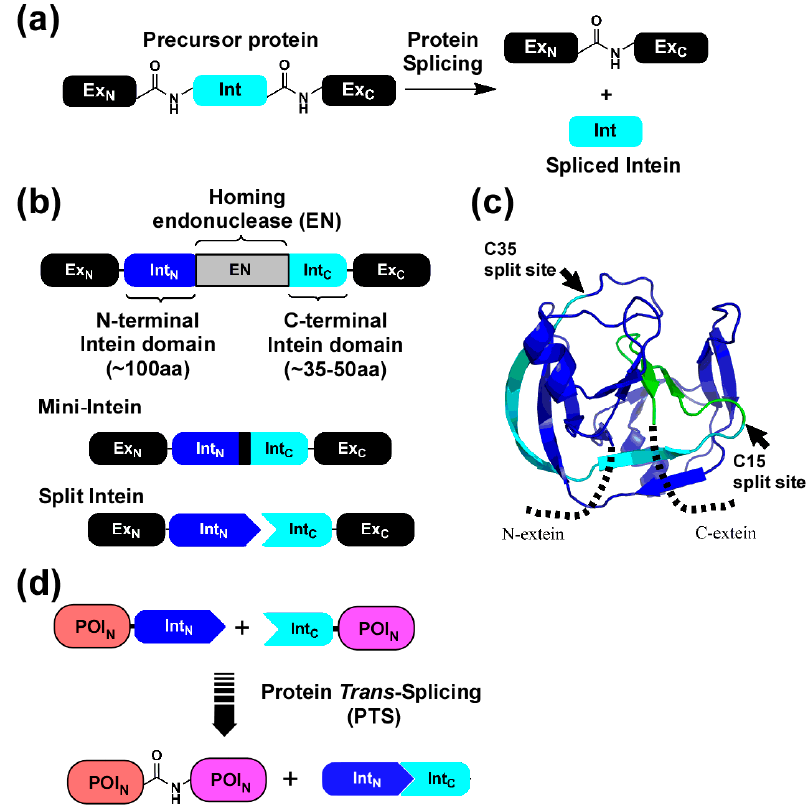
Figure 2. Protein splicing in cis and trans. ( a ) Protein splicing in cis . An internal protein (Intein, Int) is spliced out from a precursor protein, concomitantly ligating the two flanking proteins (N-extein and C-extein). Ex N and Ex C indicate N-extein and C-extein, respectively. ( b ) Canonical intein with homing endonuclease domain (EN), Mini-intein without EN, and split intein. ( c ) A cartoon model of Npu DnaE intein [20,21]. The natural split-site (C35) and engineered split-site (C15) are marked with arrows [22]. The N-terminal split fragment of the natural split intein is colored in blue. Int N used in this study is colored in blue or cyan. The region corresponding to the Int C fragment used in this study is highlighted in green. ( d ) Protein ligation by PTS using a split intein. PTS ligates the N-terminal fragment of a protein of interest (POI N ) fused with the N-terminal split intein (Int N ) and the C-terminal fragment of POI (POI C ) fused with the C-terminal split intein (Int C ). PTS results in ligated POI N -POI C and excised Int N and Int C . The figures were adapted from [5].